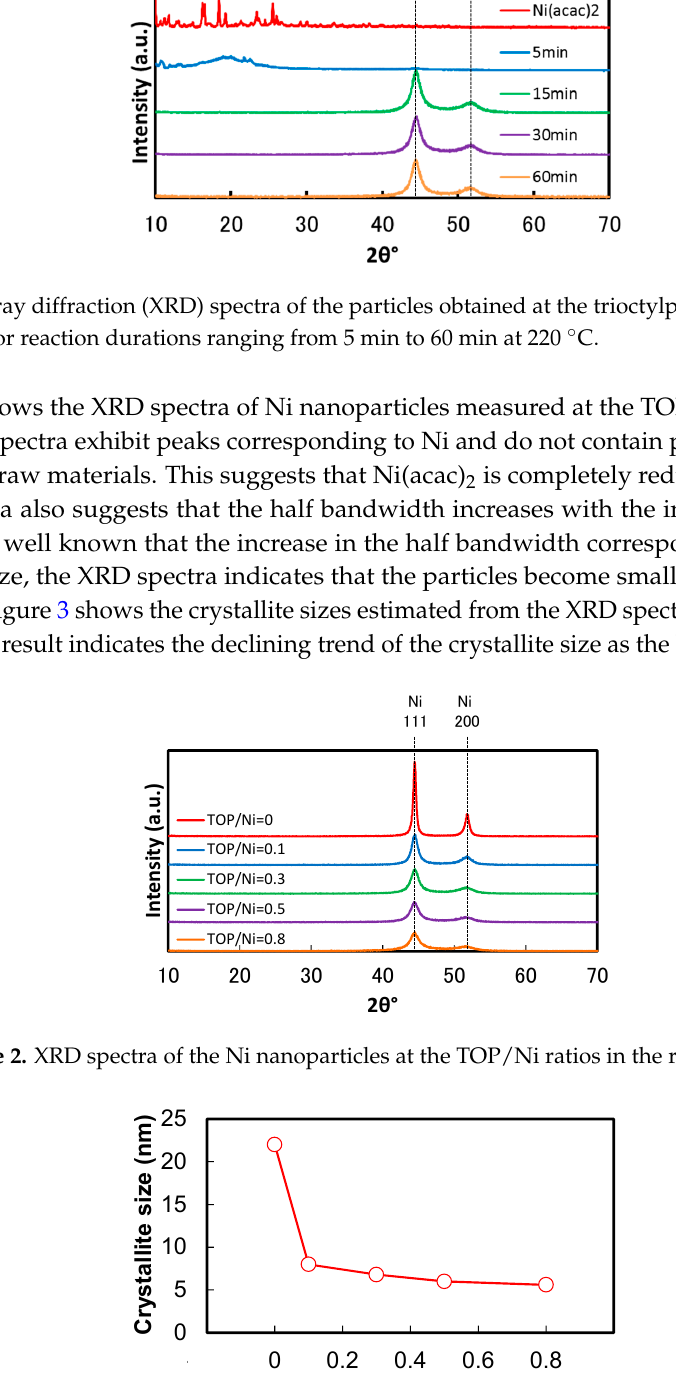
Figure 3. Crystallite sizes of Ni nanoparticles at the TOP/Ni ratios in the range of 0–0.8.